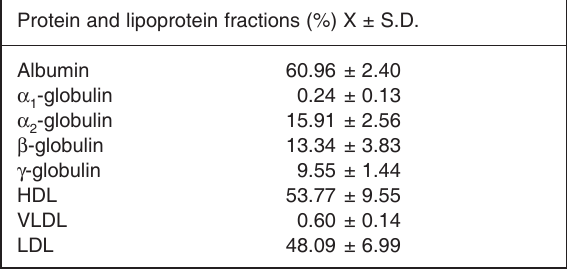
TABLE 2 Serum protein and lipoprotein fractions* of the ostrich Protein and lipoprotein fractions (%) X ±